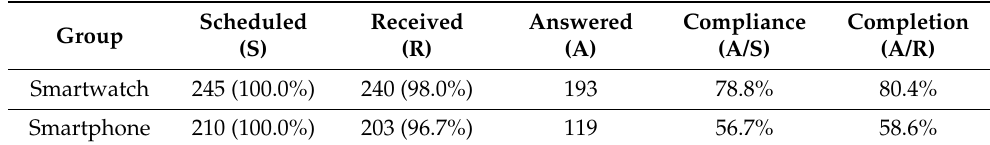
Table 1. Number of scheduled, received, and answered notifications, alongside resulting compliance and completion.